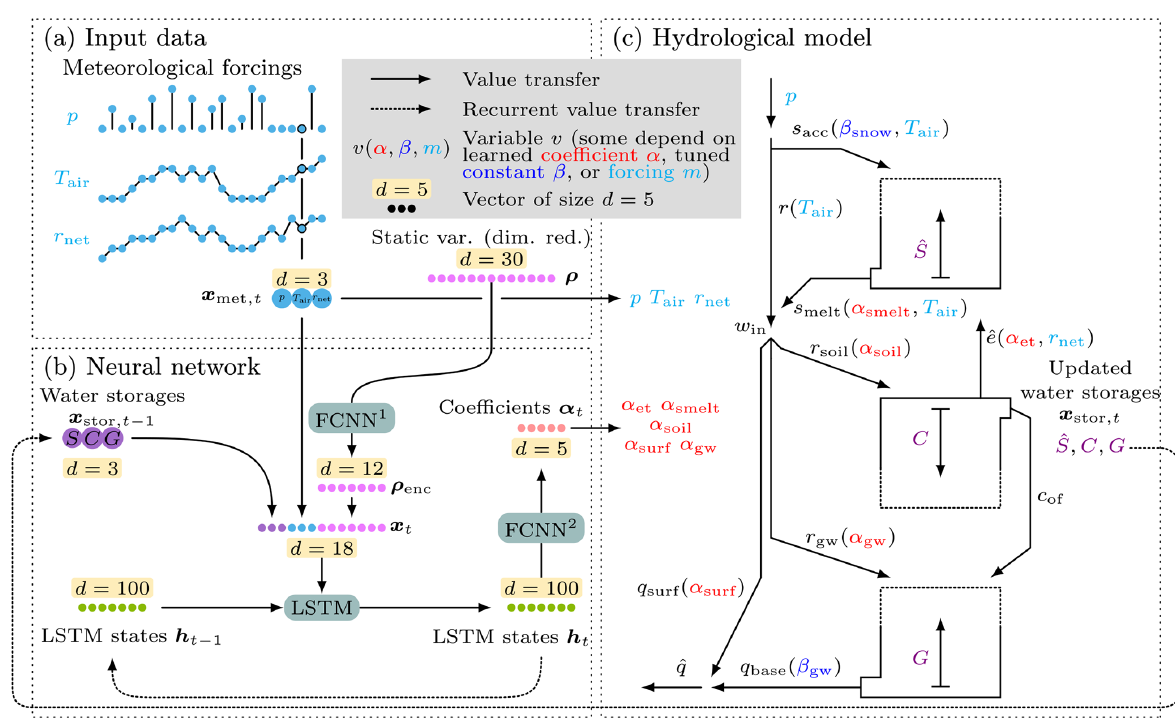
Figure 1. In the H2M, a (b) dynamic neural network (NN) simulates a set of time-varying coefficients that are used in a simple (c) hydro- logical model. The meteorological forcings x met ,t at time t are used as input (a) to the NN and to the physical equations. The NN contains a long short-term memory (LSTM) layer and two fully connected networks (FCNNs). The model maintains two sets of states, namely the (physical) water storages x stor and the LSTM’s internal (non-physical) state h (cell state omitted here). It is conditioned on additional inputs representing static land surface and soil properties ρ and the previous water storages x stor ,t − 1 . The NN module yields five time-varying coefficients ( α ) which are used in the balance equations. In total, two global parameters ( β ) are estimated independently from the data in- put directly by the optimizer. The location of usage in the balance equations is indicated in parentheses, ( ˆ· ) denotes the variables that are constrained with observations, and upper case variables are storages. Forcings (cyan): p – precipitation; T air – air temperature; r net –